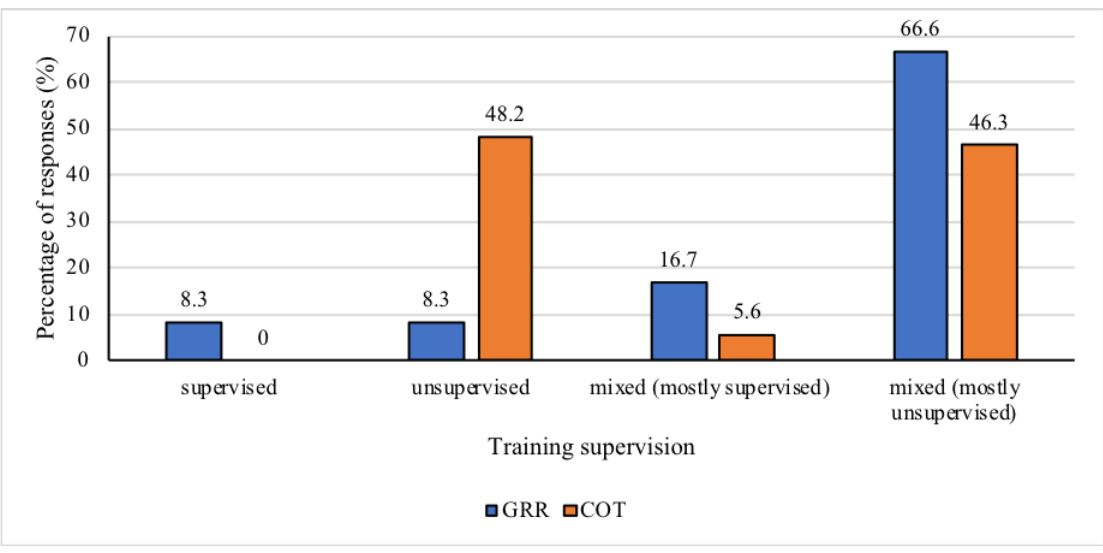
Figure 2. Percentage of responses to training supervision for both special operations units, chosen from supervised, unsupervised, mixed (but mostly supervised), or mixed (but mostly unsupervised). COT = Tactical Operations Command; GRR = Rapid Response Group.